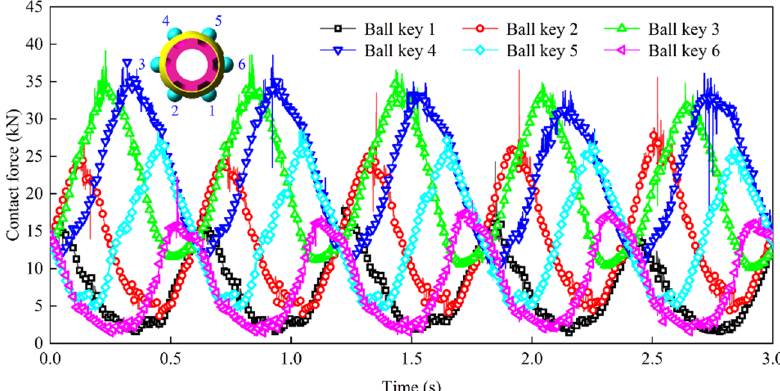
Figure 11. Variation in the contact force on ball keys.